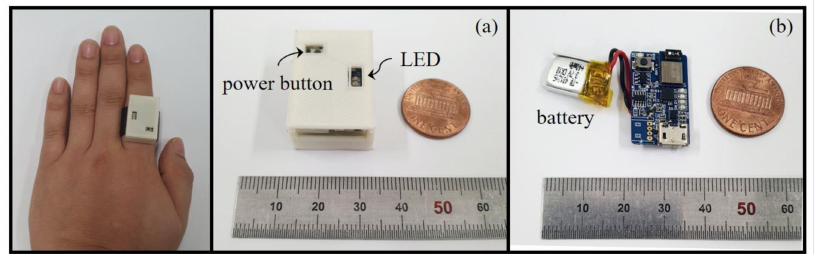
Figure 1. Smart-ring-based chest compression feedback device. ( a ) Overall CPR Smart Ring. ( b ) Elec- tronic circuit board of the CPR Smart